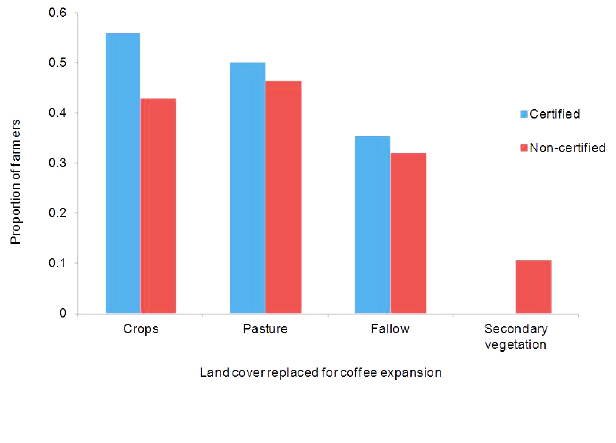
Fig. 2 . Land cover replaced by certified and noncertified farmers to expand coffee